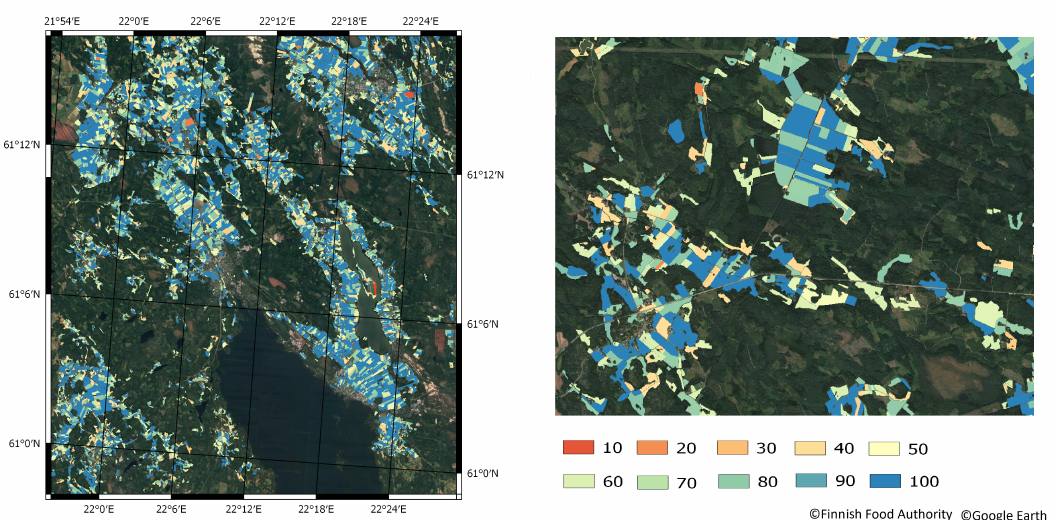
Figure 7. An example of a map of the probability of the predicted crop species with the field parcel boundaries, c (cid:13) Finnish Food Authority, c (cid:13) Google